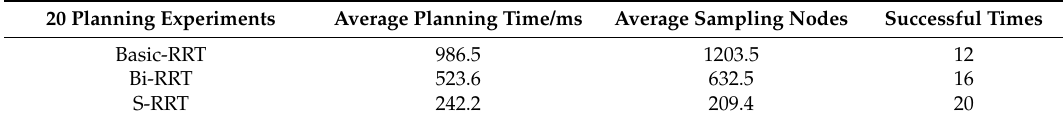
Table 2. Simulation results with different algorithms.